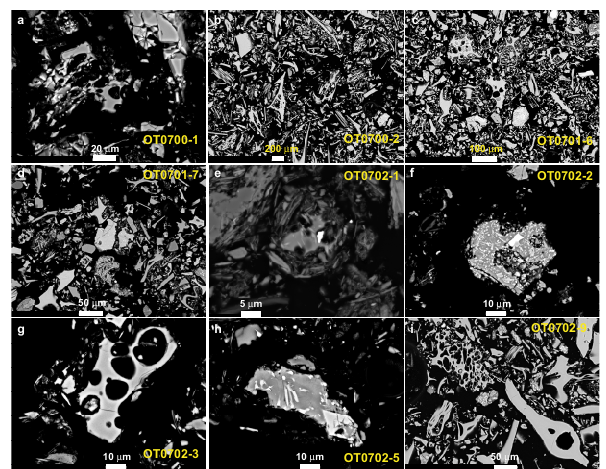
Fig. 4. SEM photographs of volcanic fragments from selected tephra layers and cryptotephras. (a) Y-3 tephra layer in core Co1200; (b) CI/Y-5 tephra layer from core Co1200; (c) C-20 cryp- totephra in core Co1201; (d) X-5 tephra layer in core Co1201; (e) AD 472 cryptotephra in core Co1202; (f) FL cryptotephra in Co 1202 core; (g) Mercato cryptotephra in Co1202 core; (h) Codola cryptotephra in core Co1202; (i) X-6 tephra layer core